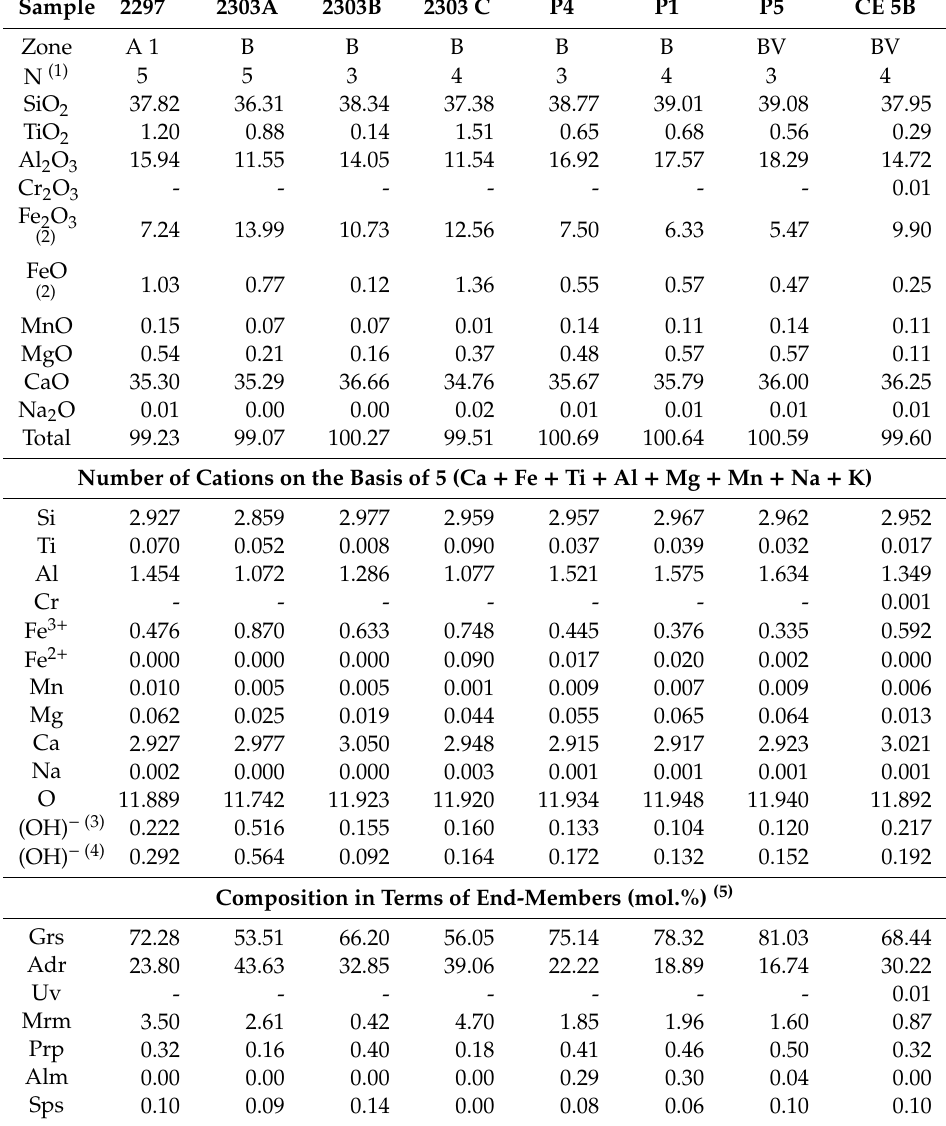
Table 4. Representative compositions of grossular I , M ă gureaua Va¸tei